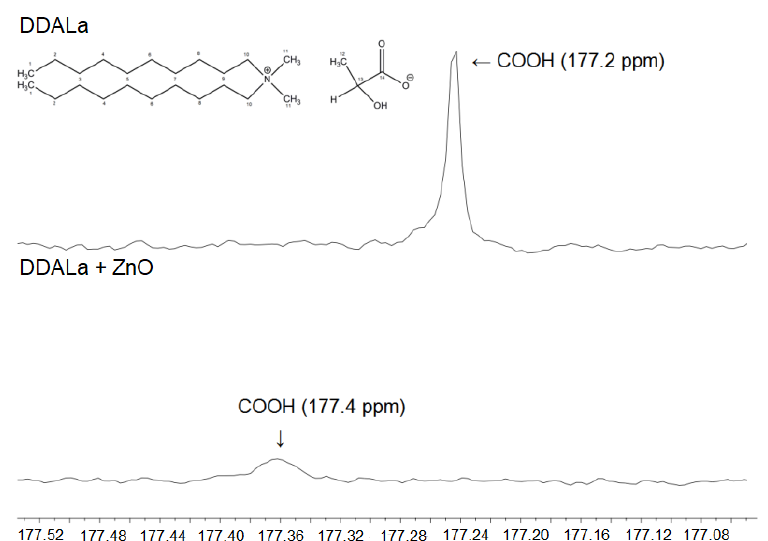
Figure 14. 13 C NMR spectra for 1:2 DDALa and ZnO mixture—identification of interactions.